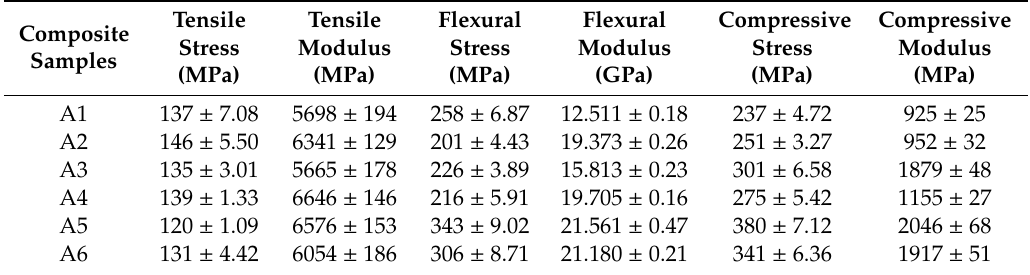
Table 3. Mechanical properties of GF / SF / CTS composite sca ff